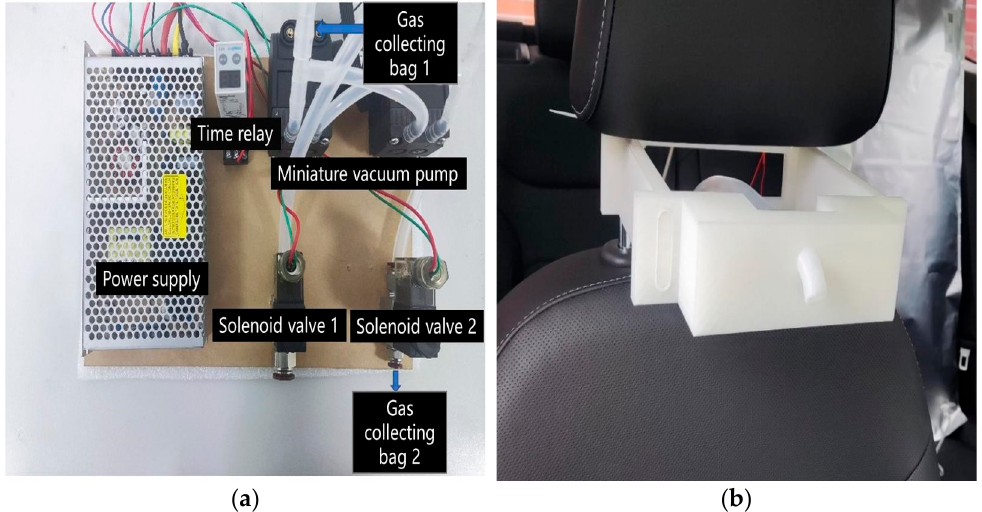
Figure 2. ( a ) Picture of simulated exhalation device; ( b ) Picture of exhalation port structure.